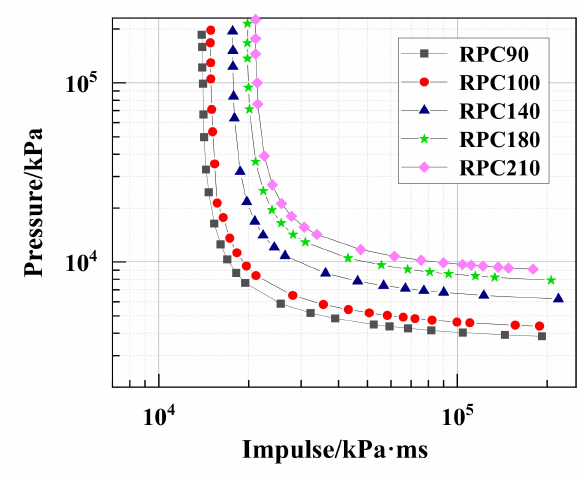
Figure 18. P-I curves of bending damage with different RPC strength.